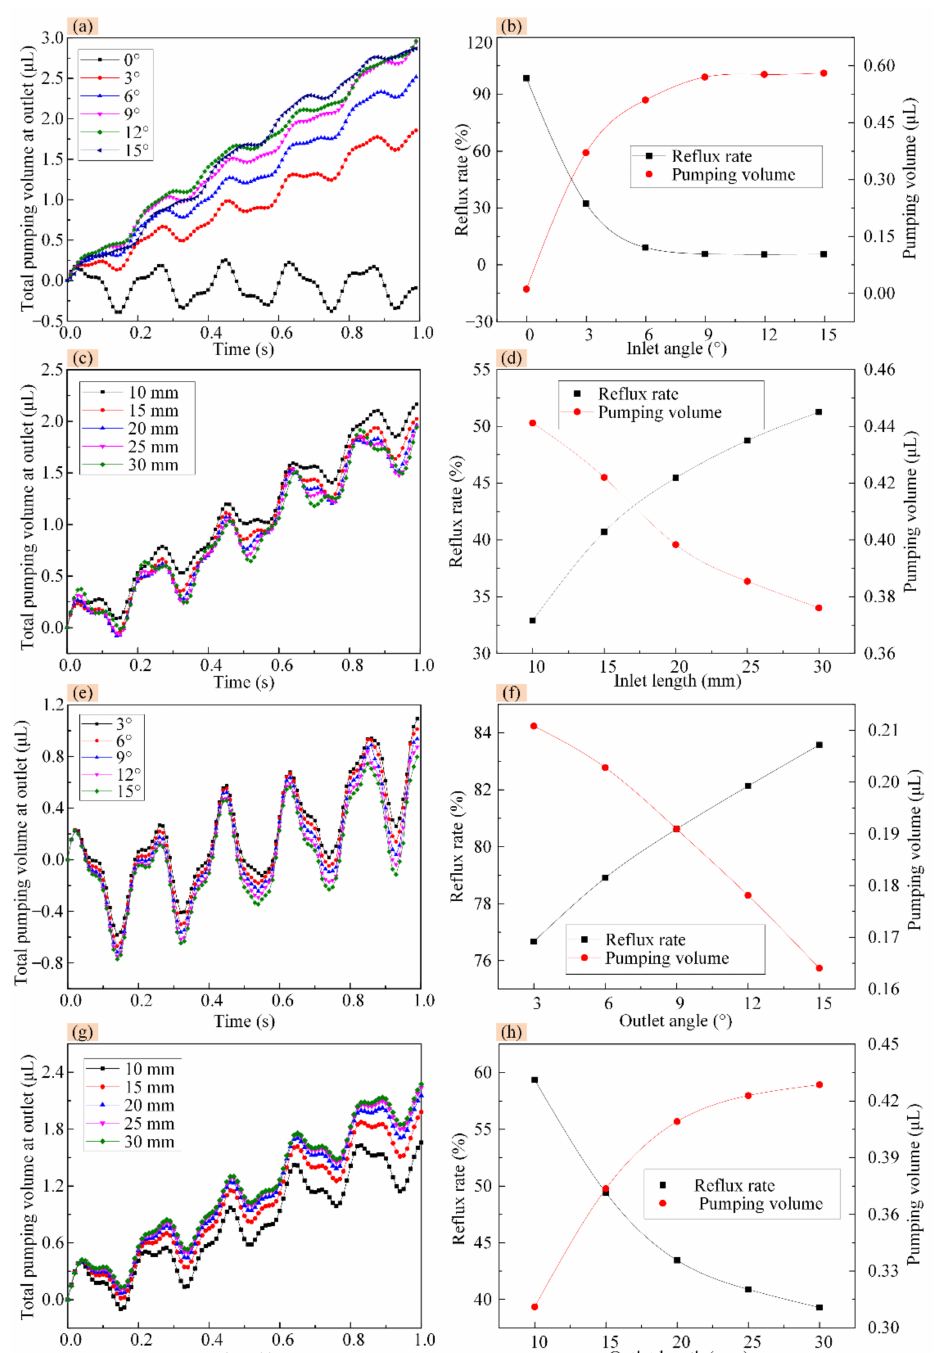
Figure 7. The pumping performance of the designed valveless piezoelectric micropump with different inlet/outlet structure sizes: ( a , b ) the pumping performance when applying different inlet angles; ( c , d ) the pumping performance when applying different inlet lengths; ( e , f ) the pumping performance when applying different outlet angles; ( g , h ) the pumping performance when applying different outlet